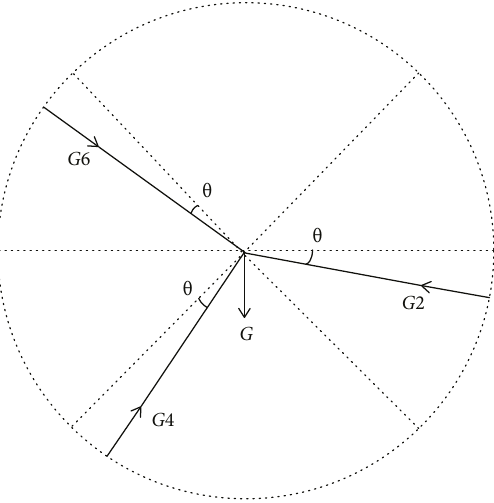
Figure 4: Force deformation diagram of the suction cup.